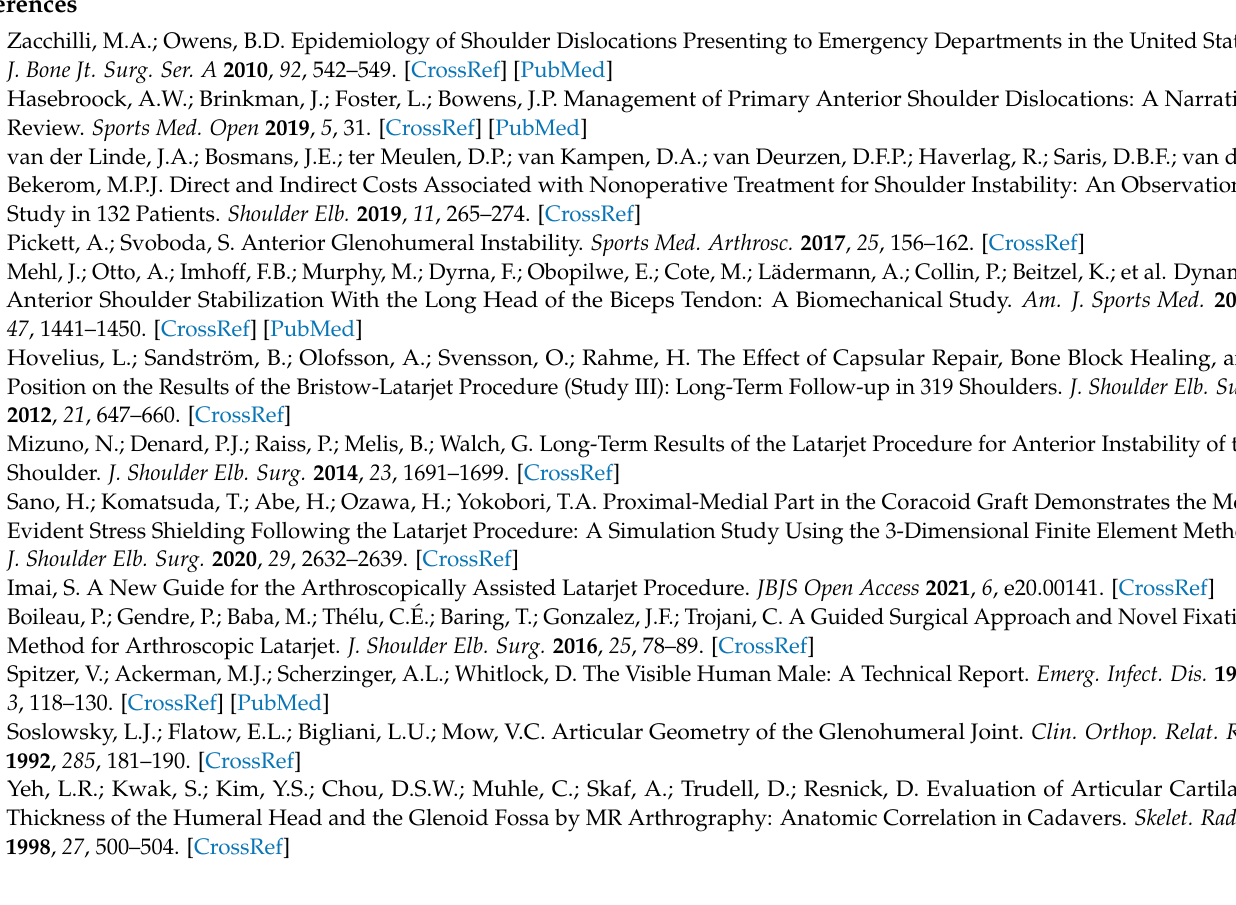
translation force. Results correspond to the 60 ◦ shoulder abduction in the scapular plane with 45 ◦ of external rotation under a 50 N compressive force. Each bone graft position presents its own scale; Figure S7: Contact pressure distribution, in MPa, after the Latarjet procedure for two anterior translation points: (a) at the beginning, and (b) at the peak translation force. Results correspond to the 60 ◦ shoulder abduction in the scapular plane with 45 ◦ of external rotation under a 100 N compressive force. A similar scale is considered for all bone graft positions; Figure S8: Contact pressure distribution, in MPa, after the Latarjet procedure for two anterior translation points: (a) at the beginning, and (b) at the peak translation force. Results correspond to the 60 ◦ shoulder abduction in the scapular plane with 45 ◦ of external rotation under a 100 N compressive force. Each bone graft position presents its own